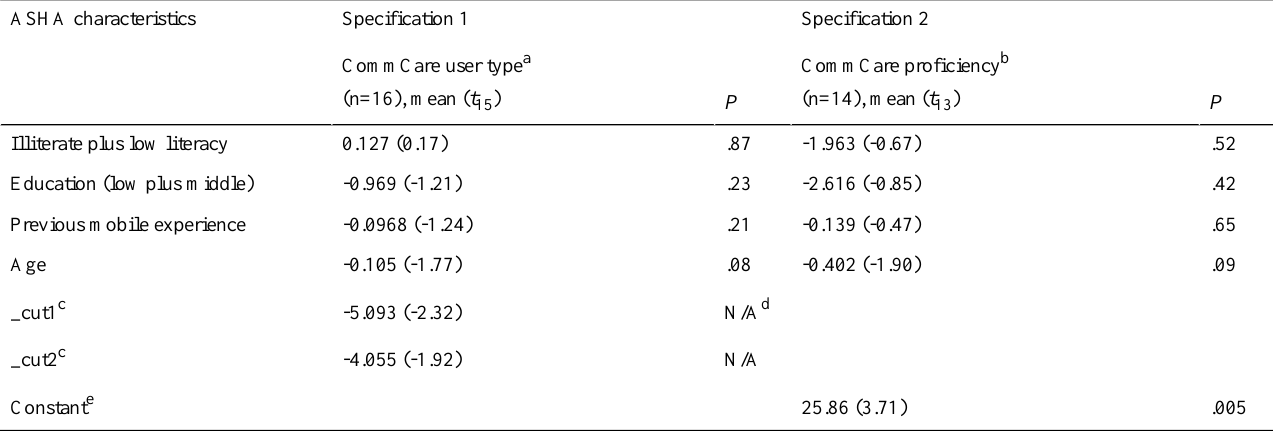
Table 9. Relationship between CommCare adoption and ASHA